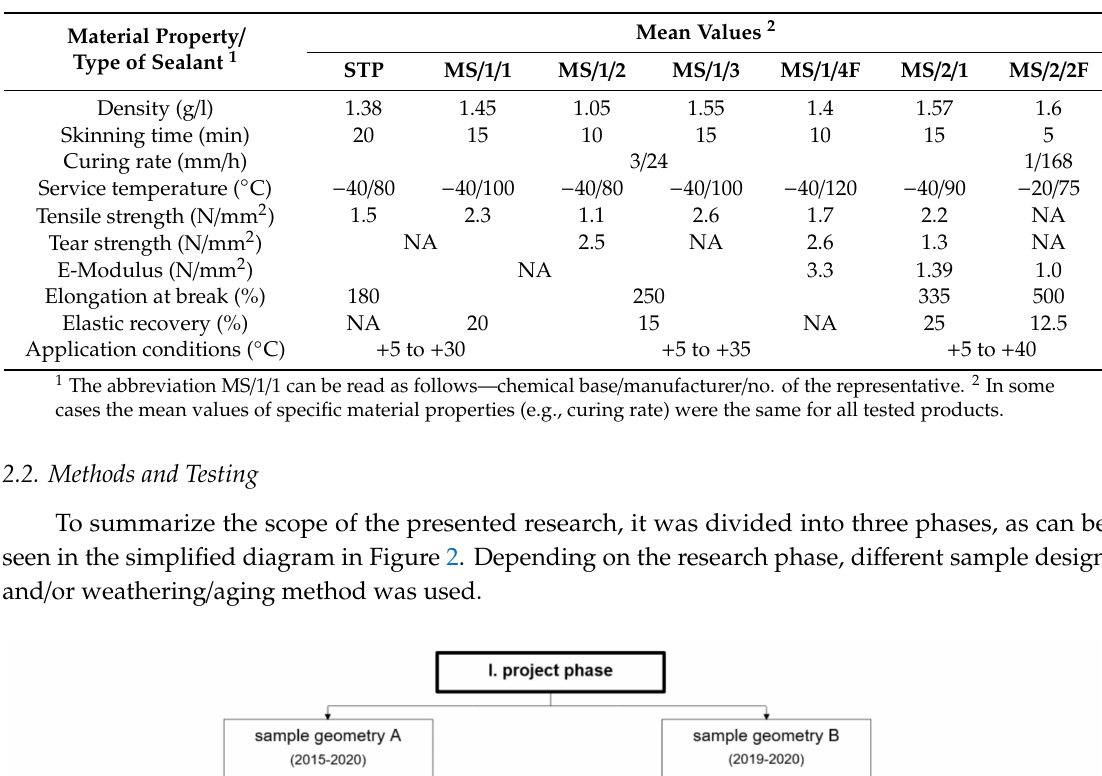
Table 3. Technical data and physical / mechanical properties of silyl / silane modified polymers.